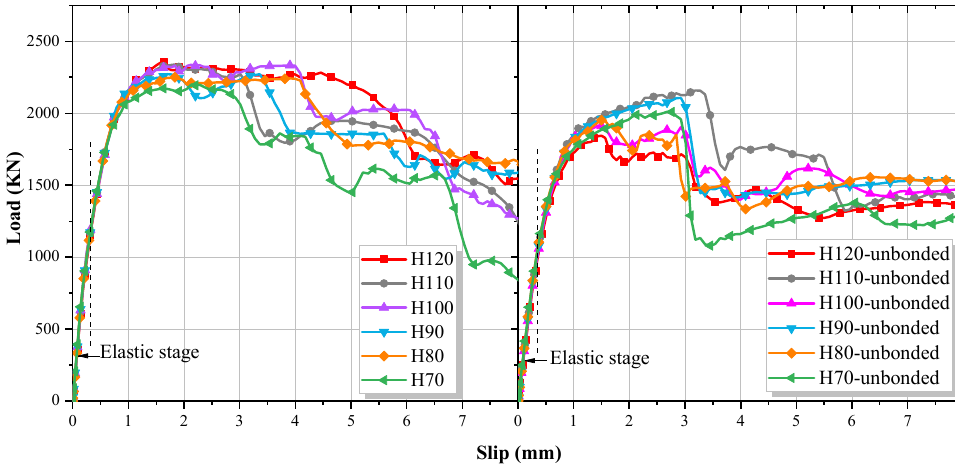
Figure 20. Load-slip curves of specimens with different stud height.